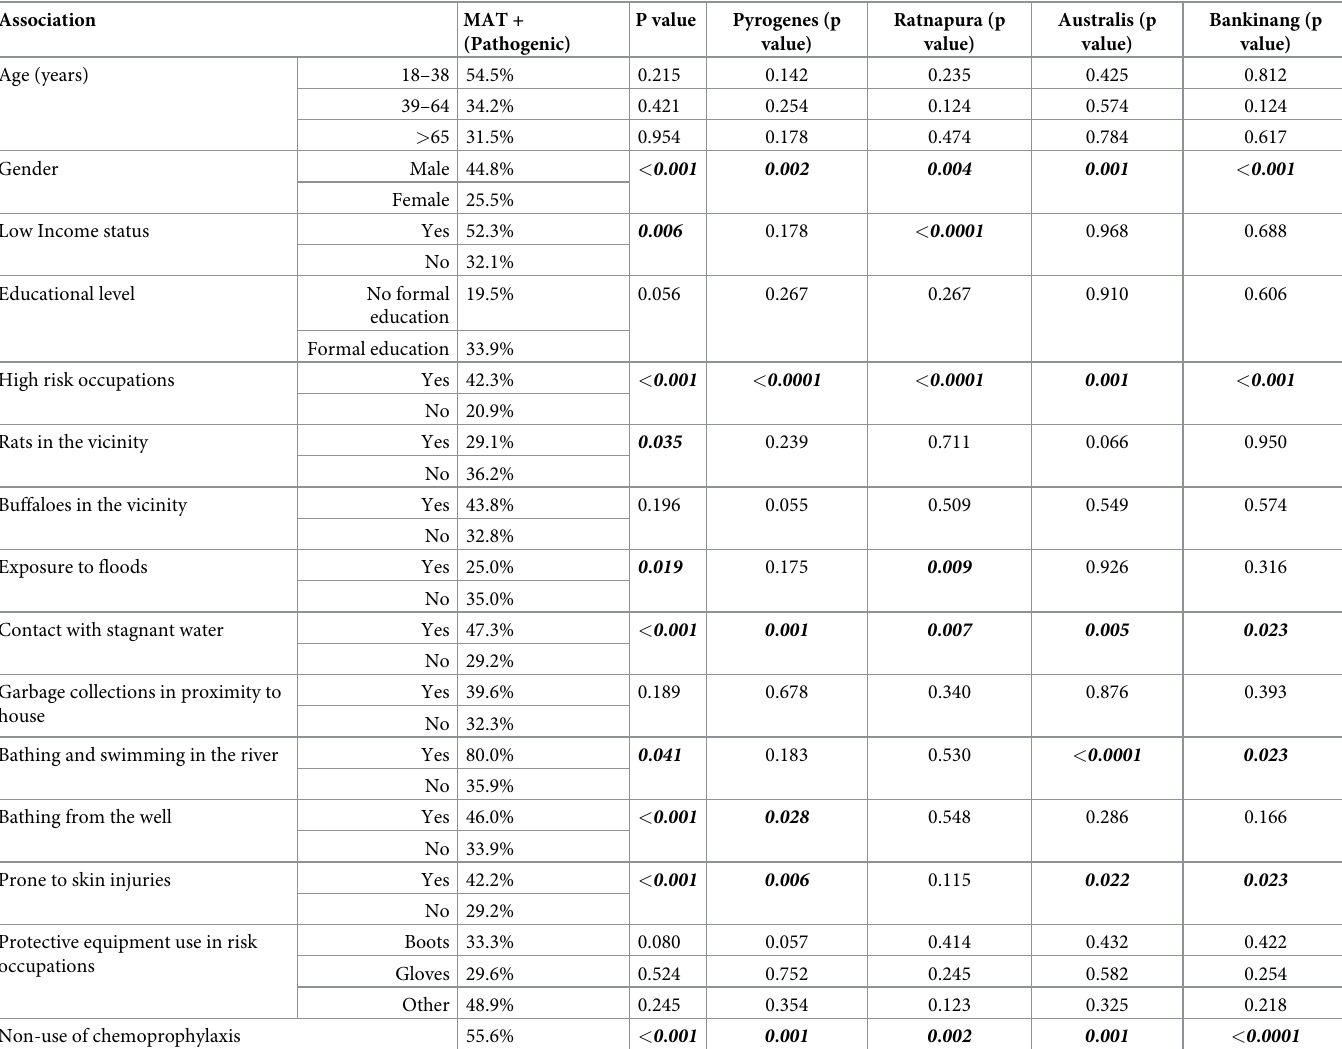
Table 6. Associations of pathogenic MAT